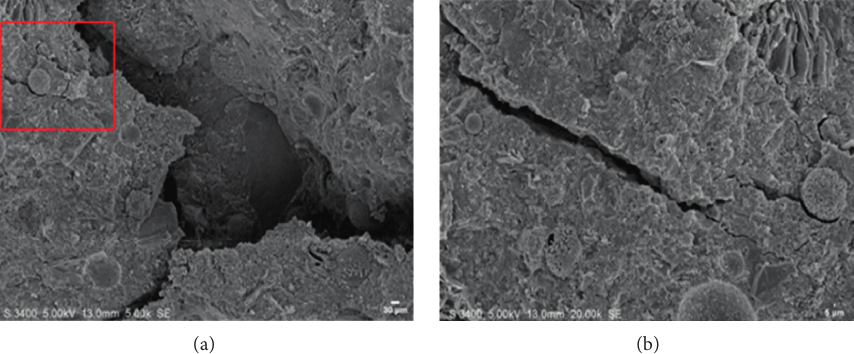
Figure 12: 90 freeze-thaw cycles. (a) SEM image of CRC. (b) Partially enlarged view of matrix cohesiveness.